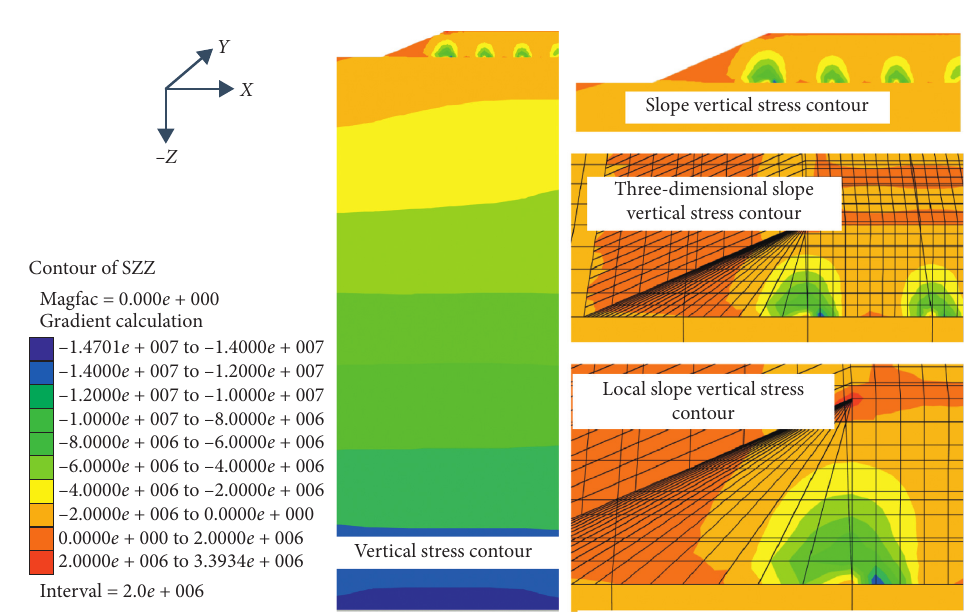
Figure 5: Cloud chart of the overall vertical stress after initial in situ stress